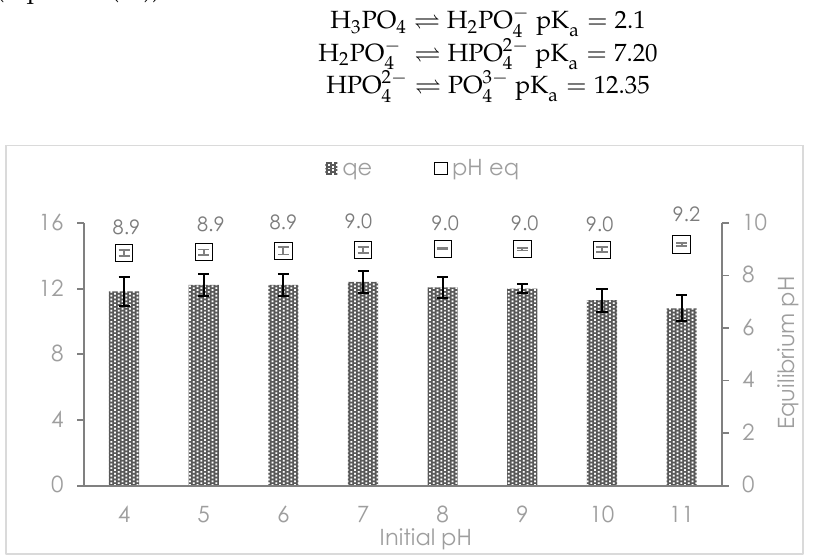
Figure 4. Phosphate adsorption capacity as a function of the pH and equilibrium pH.